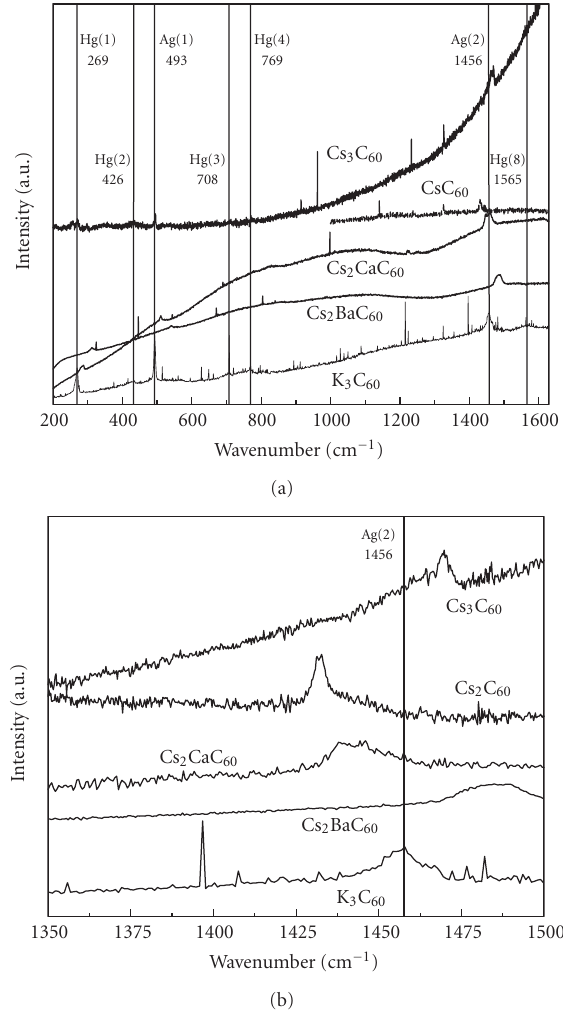
Figure 4: Raman scattering spectra of fullerides Cs 2 C 60 , Cs 3 C 60 , and Cs 2 MC 60 (M = Ca, Ba) obtained at (a) room temperature and (b) Raman spectra in the range near line Ag(2) of K 3 C 60 for the same fullerides.